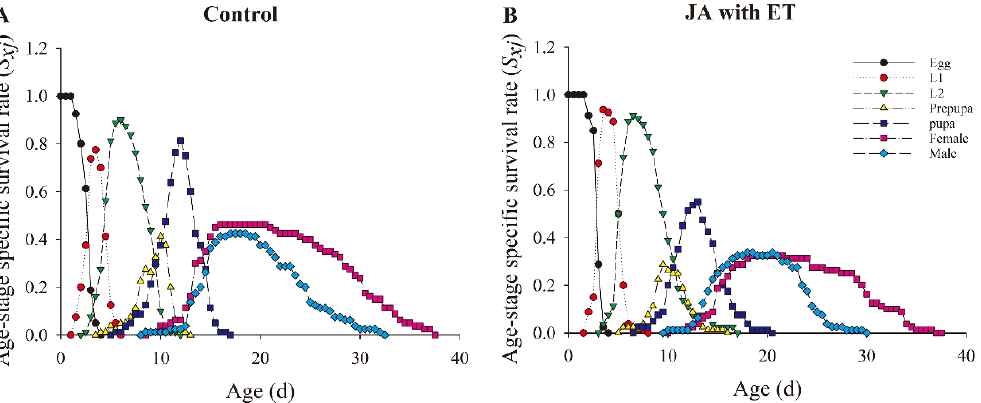
Figure 6. Effect of the JA with ET treatment on the age-stage-specific survival rate ( S xj ) of Frankliniella occidentalis grown on faba bean plants. ( A ) Control group; ( B ) JA with ET group.